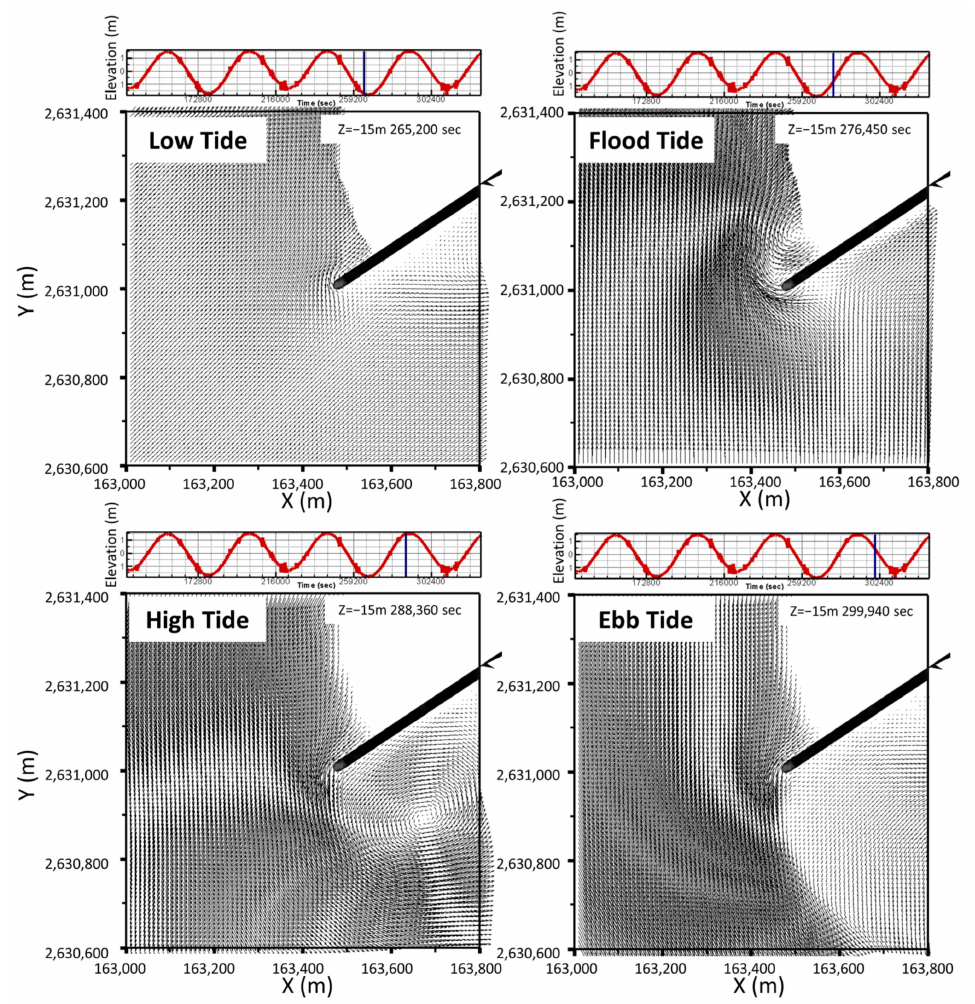
Figure 39. Depth-averaged flow velocity vector at low, flood, high, and ebb tide stages. The current field conditions of various tidal intervals are discussed as